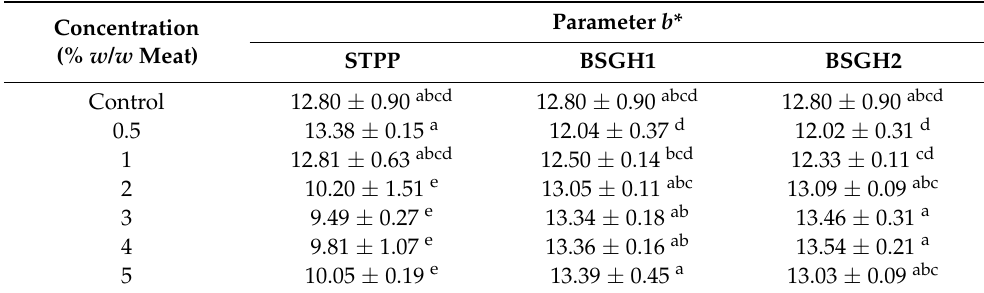
Table 4. Average values of the color parameter b * for STPP, BSGH1, and BSGH2. Results are presented as the average of three replicates ± standard deviation. Different letters indicate significant differences ( p ≤ 0.05).